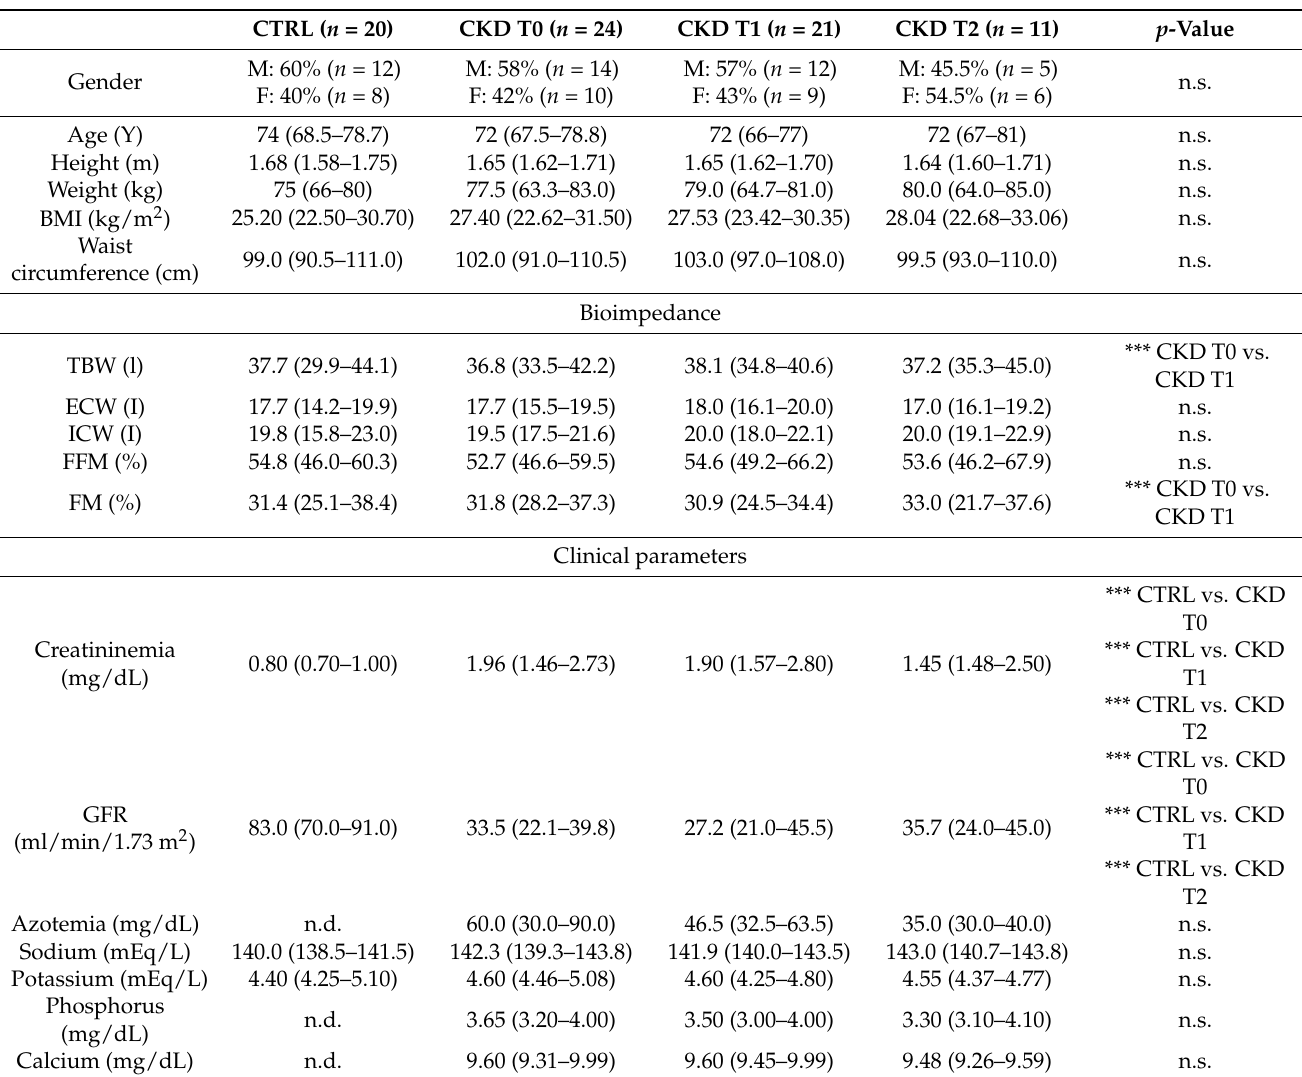
Table 1. Cohort characteristics. Data are reported as median